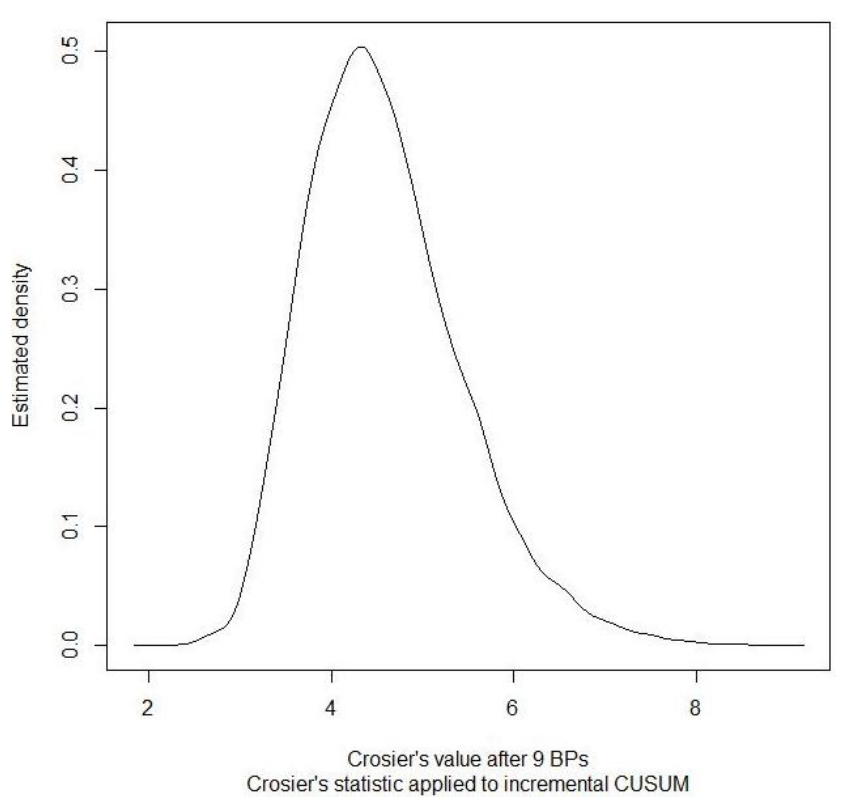
Figure 10. Example of the estimated probability density of Crosier’s statistic applied to incremental CUSUMs in the 2-part hybrid at BP 9. The data is simulated from the SPM of an electrochemical